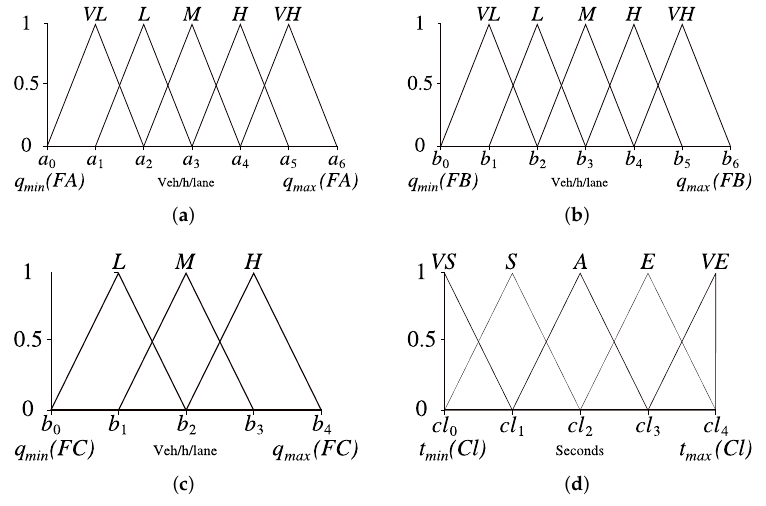
Figure 5. Fuzzy sets for the four linguistic variables: ( a ) flow rate in stream A , ( b ) flow rate in stream B , ( c ) flow rate in stream C , and ( d ) cycle length Cl